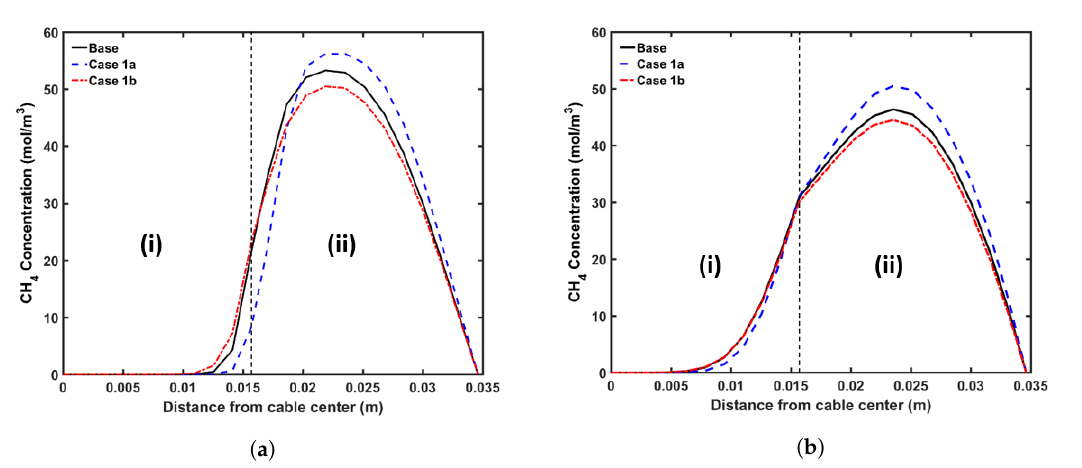
Figure 12. Radial CH 4 concentration profile for the curing temperature study at ( a ) the curing tube exit, ( b ) the cable take-up point. Segment (i) corresponds to the conductor layer and segment (ii) corresponds to the cross-linked polyethylene (XLPE) and semiconductor (SC)